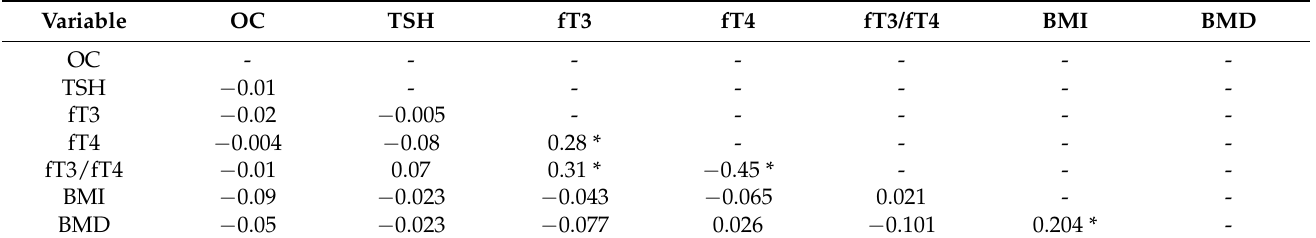
Table 2. Association between TSH, thyroid hormones, osteocalcin, BMI, and BMD in the total sample ( N =